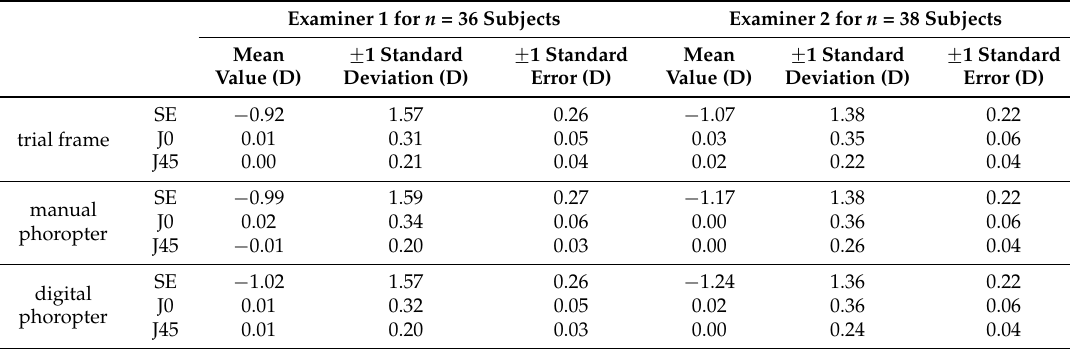
Table 1. Mean values, ˘ standard deviation and ˘ standard error for each refractive parameter (SE, J0 and J45) for examiner 1 and 2, when refraction was assessed with all